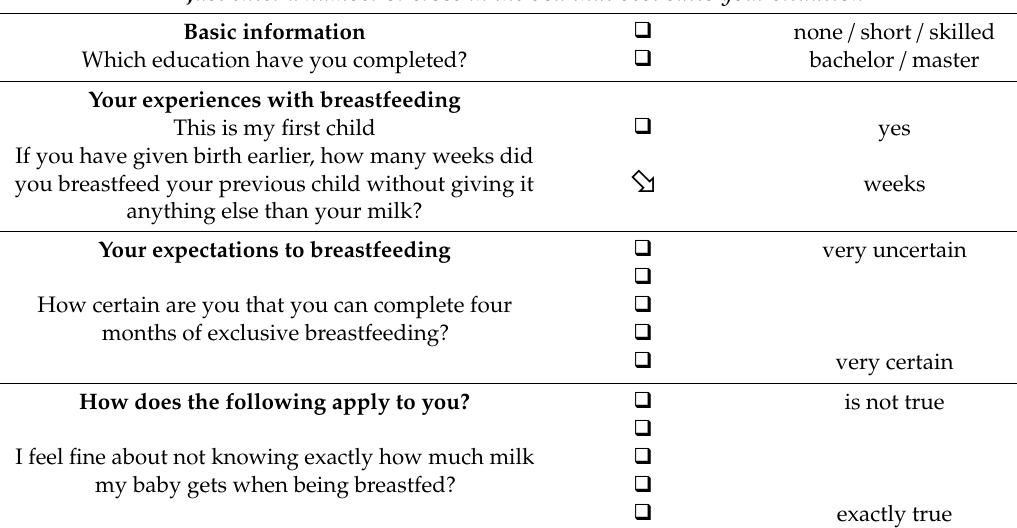
Table 4. Practical application of the breastfeeding score. The written postpartum questionnaire for mothers.